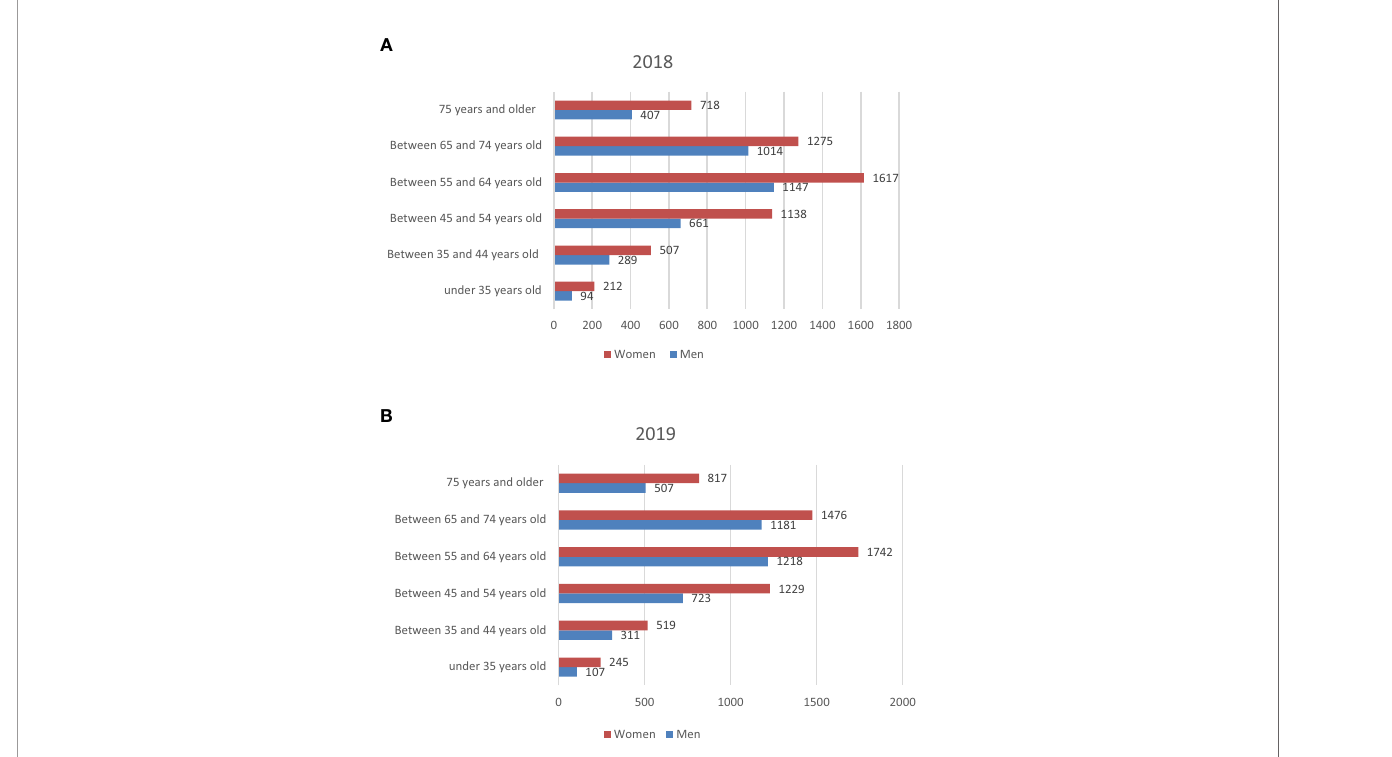
FIGURE 3 | Number of patients with diabetes by age group and gender; (A) in 2018; (B) in